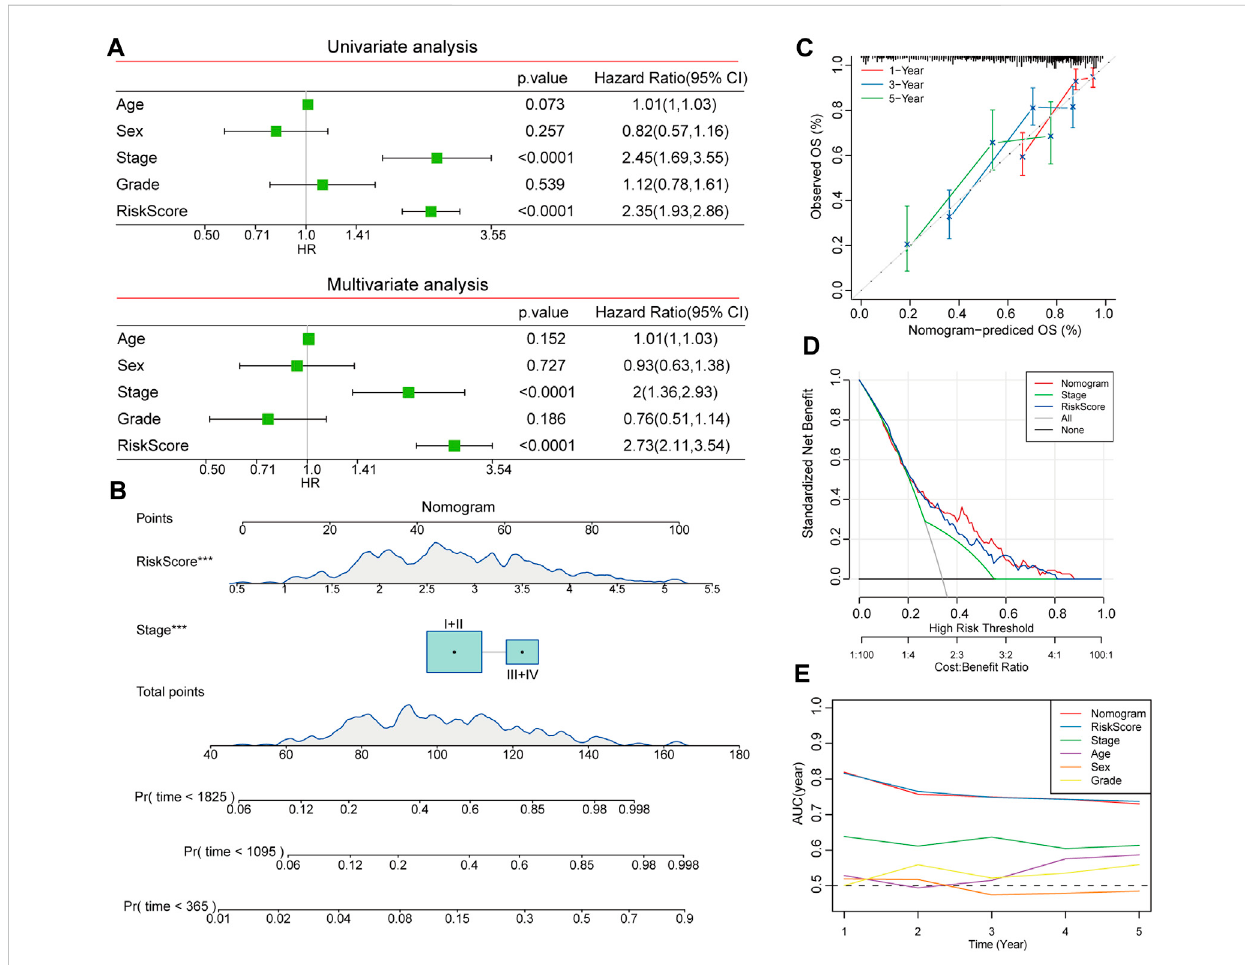
FIGURE 9 Construction of nomogram based on risk score and clinicopathological characteristics. (A) Independent prognostic factors were determined by univariateand multivariate Cox regressionanalyses. (B) Constructionof nomogram to assess thepredictiveef fi ciency of risk score. (C) Calibration curves for nomogram predicted OS and observed OS for 1 year, 3 years, and 5 years. (D) DCA curves showed the reliability of the nomogram. (E) AUCs of different clinicopathologic characteristics for 1, 2, 3, 4, and 5-year